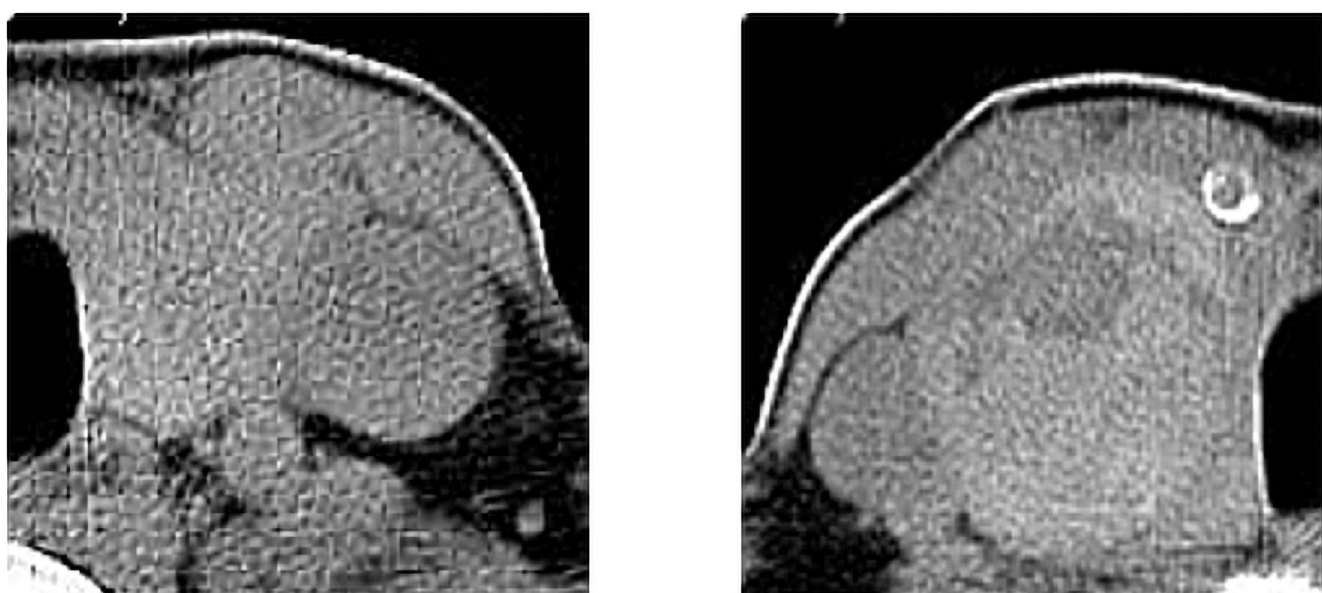
Fig 7. Segmented thyroid gland CT scans from patient No. 277: Left-side is Goiter (Benign) and right-side is Papillary Cancer (Malignant).